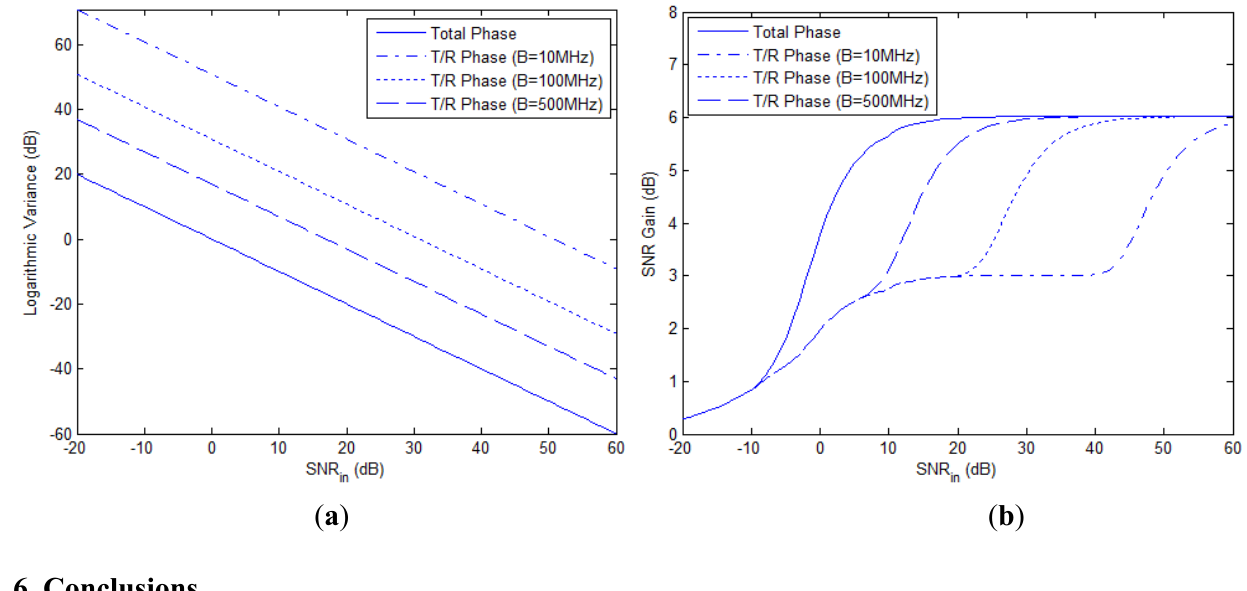
Figure 5. Comparisons between total phase differences and T/R phase differences: ( a ) the logarithmic CRB ( b ) SNR gain vs. input